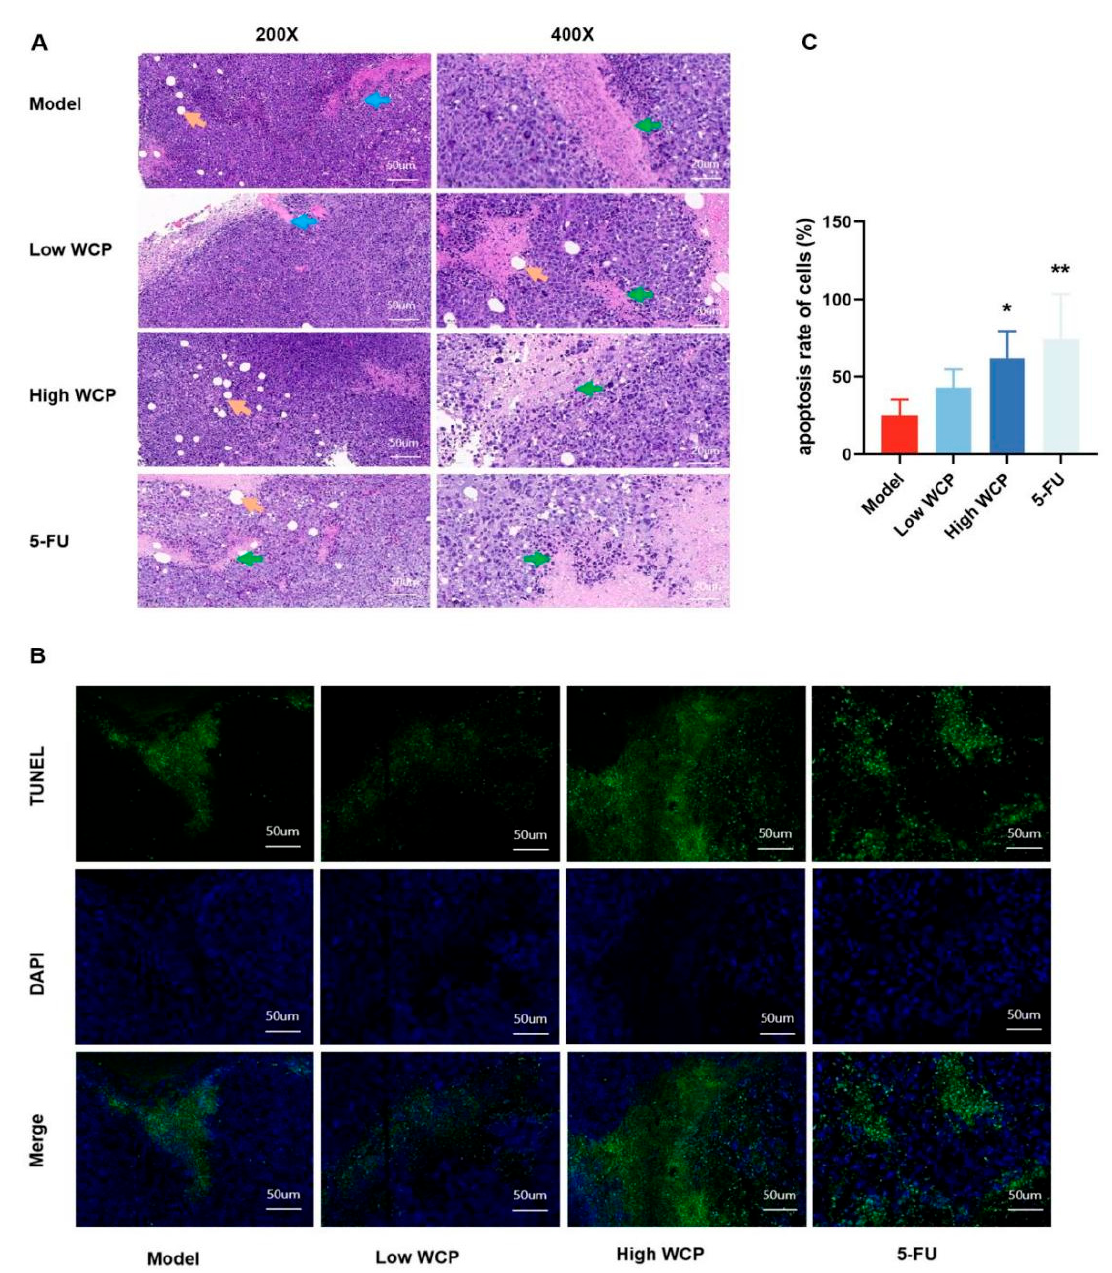
Figure 6. WCP treatment promotes apoptosis of tumor cells. ( A ) HE staining of tumors (200 × , 400 × ), scale bar = 50 µ m and 20 µ m. Green arrows represent necrotic tissue, orange arrows represent fat vacuoles, and blue arrows represent tumor cells invading muscle tissue. ( B , C ) TUNEL detection and proportions of tumor. * p < 0.05, ** p < 0.01 compared to model group.